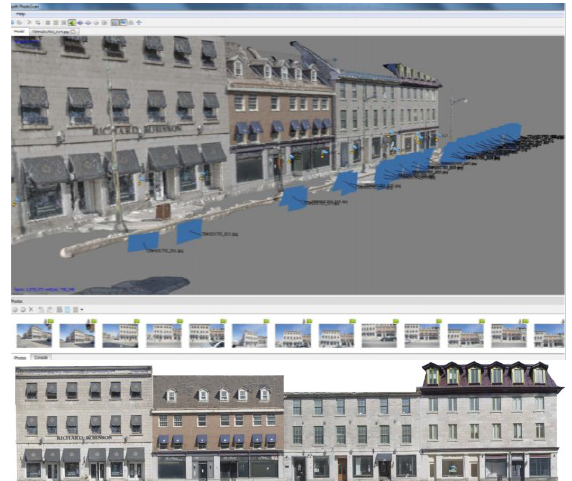
Figure 4: From photogrammetric project to orthophoto